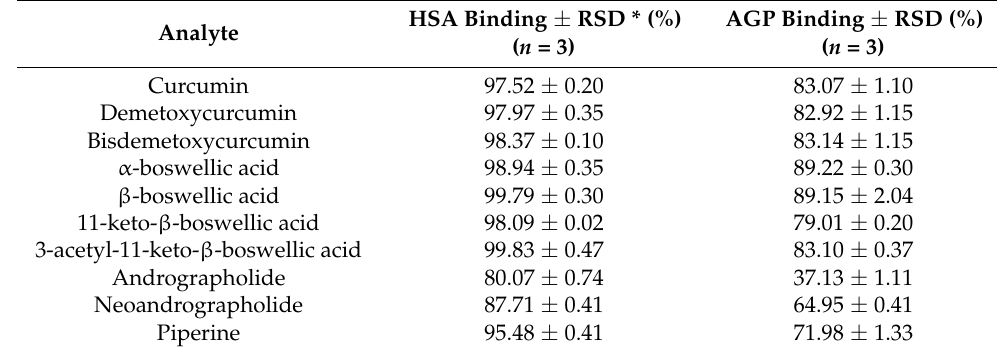
Table 5. Plasma protein binding data (%) determined by HSA-HPAC and AGP-HPAC assays. HSA Binding ± RSD * (%) Analyte